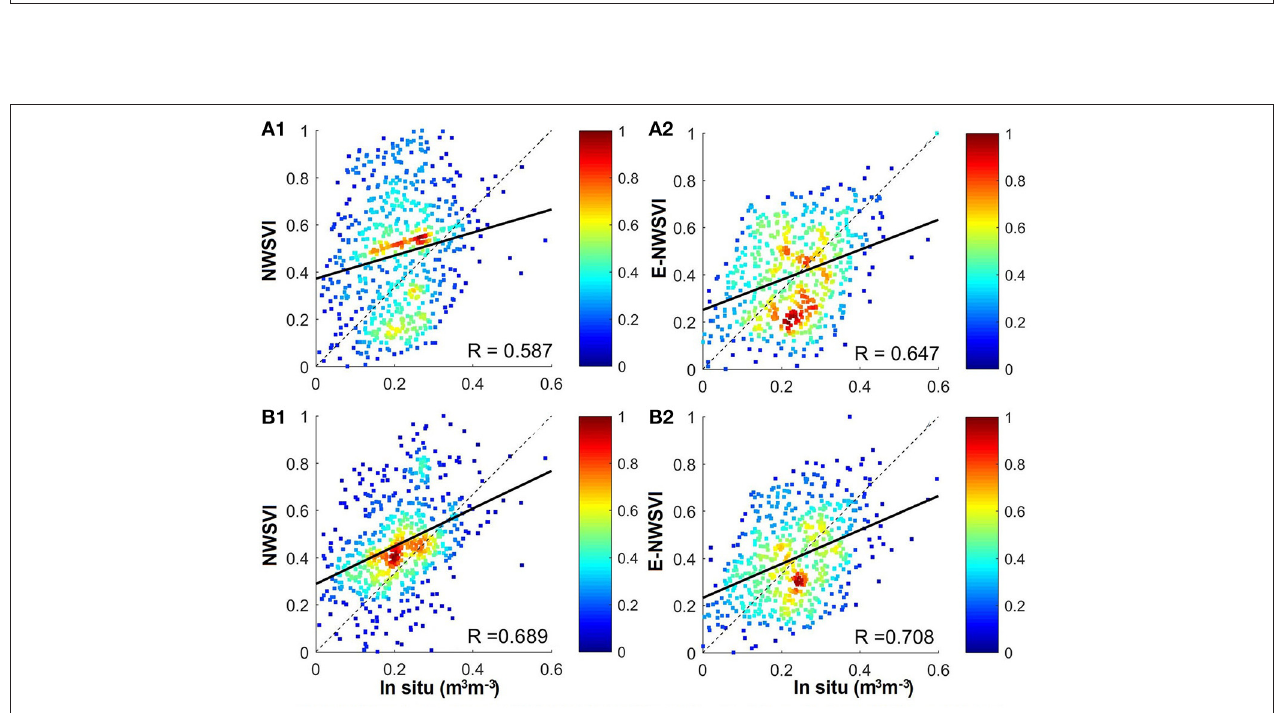
FIGURE 6 | Comparision of NWSVI/E-NWSVI with in situ SM on March 1, 2018 and April 1, 2018, (A) March 1, 2018; (B) April 1, 2018.